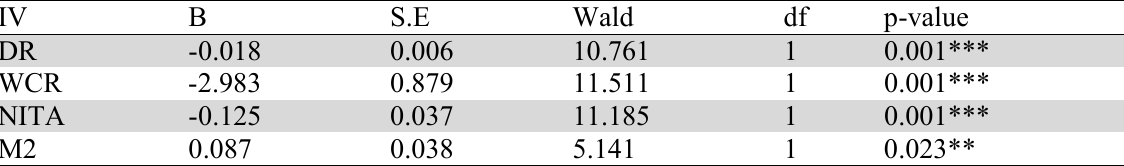
Estimation results of Logit Analysis in the non-manufacturing